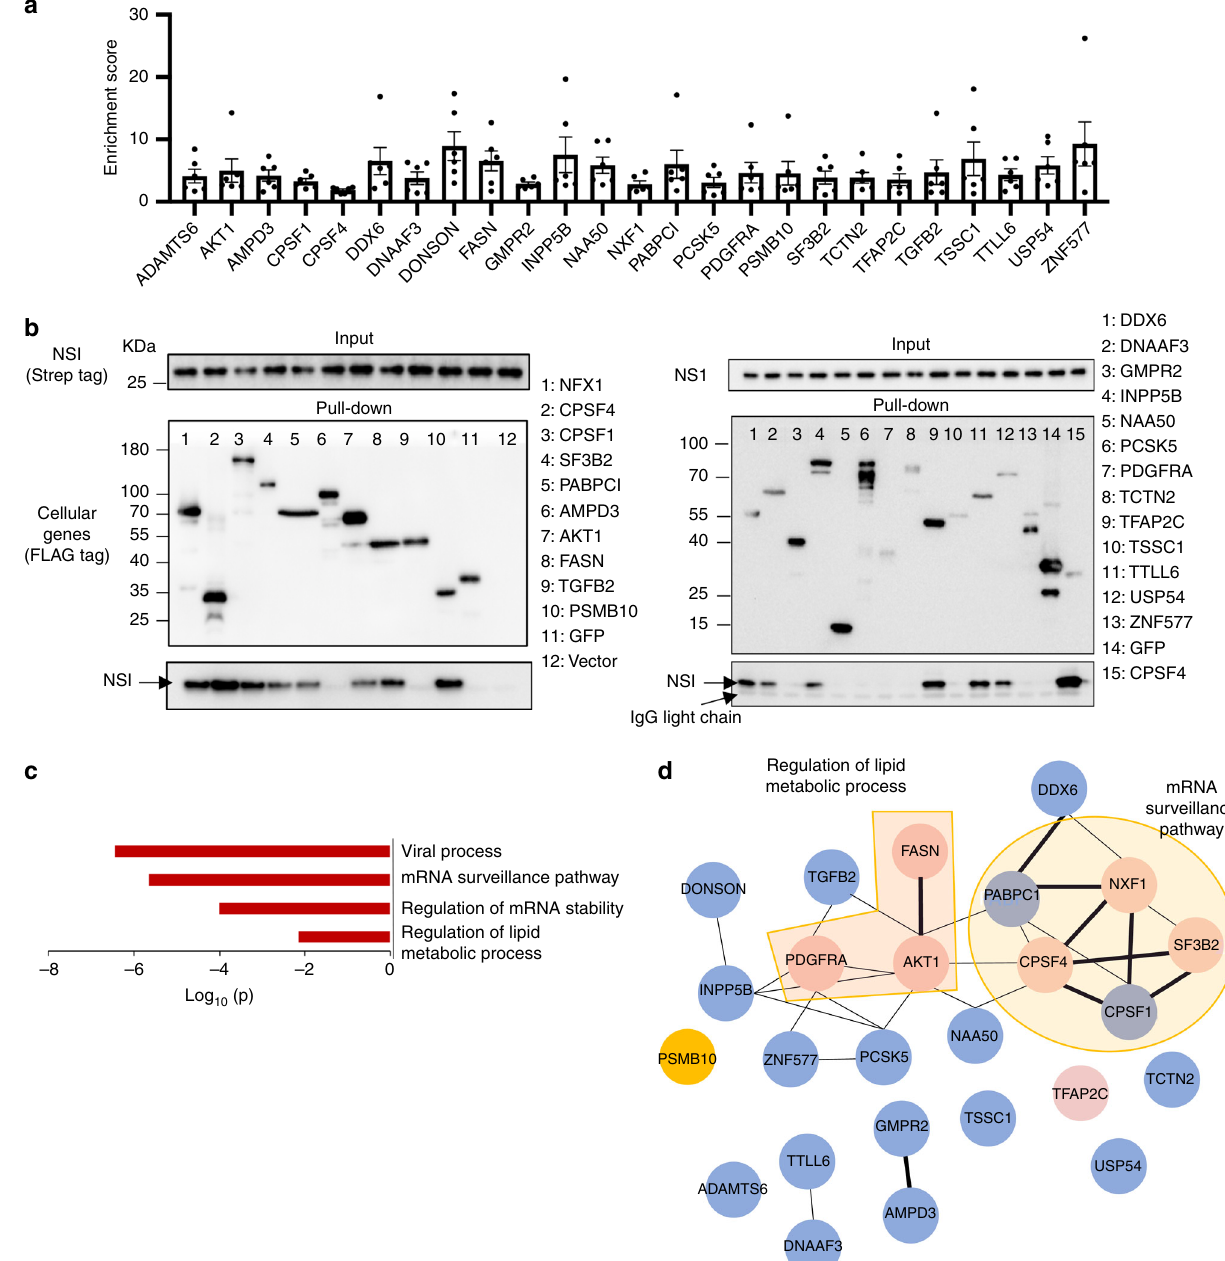
Fig. 2 Identi fi cation of cellular interactors of in fl uenza NS1 protein. a Cellular proteins identi fi ed to be interacting with NS1. The corresponding enrichment score is shown ( N = 6 biologically independent samples). Data are presented as mean values + / − SEM. b Interactions between NS1 protein and indicated cellular binders were examined by immunoprecipitation (IP)-western. Strep-tagged NS1 protein and one of the FLAG-tagged cellular proteins were co-expressed in 293T cells. Cells were lysed 48-h post transfection. Cellular proteins were pull-down with FLAG beads and detected for co-eluted NS1 protein using antibody against Strep or NS1. Four biological replicates were performed, and a representative experiment is shown. c GO enrichment analysis of genes that were identi fi ed to be interacting with NS1 through md-LED. Metascape was applied for this analysis, which utilized the hypergeometric test and Benjamini – Hochberg p -value correction algorithm. d Cellular interaction network of NS1 binders. Interactions with con fi dence >0.15 in STRING database were included. Each node represents a cellular binder, and the width of edge represents the con fi dence level of interactions. Pink nodes are known host-dependent factors, and the orange nodes are host-restriction factors for in fl uenza viral replication, extracted from the IAV database. The light yellow circle indicates the cluster of genes involved in mRNA surveillance. The orange shade indicates the cluster of genes in the pathway of regulation of lipid metabolic process. Source data for a is provided in Supplementary Data 1. Source data for b is provided in Source Data fi